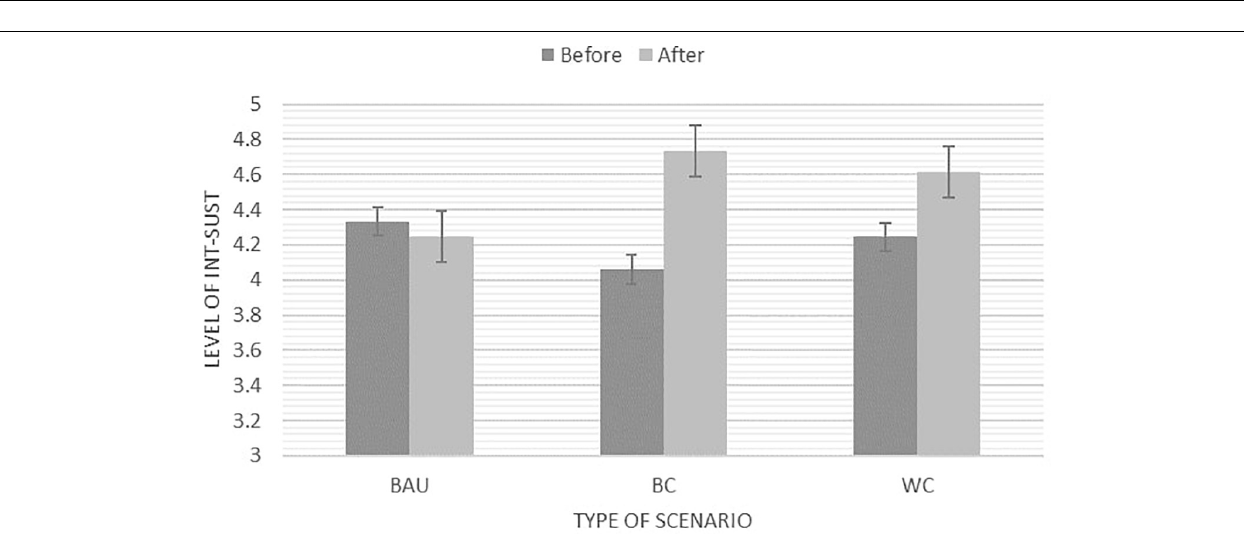
Case Scenario showing the strongest effects as visualised in Figure 8